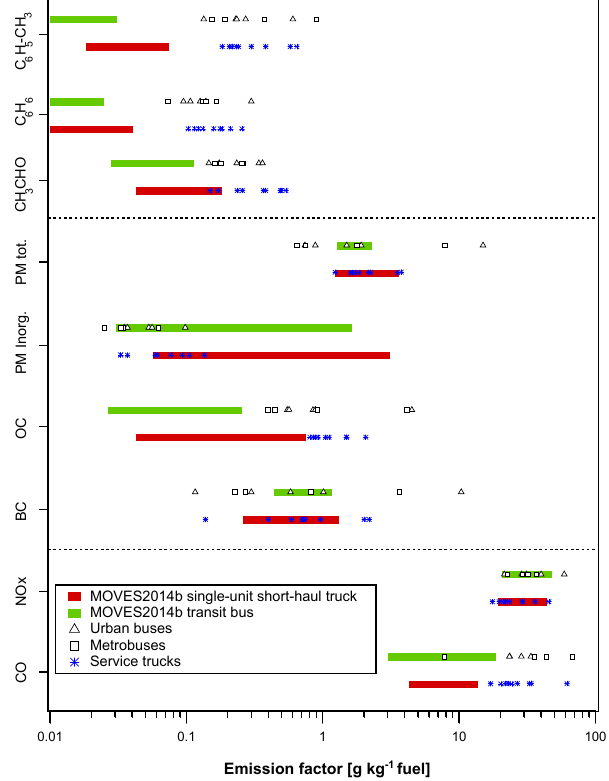
Figure 5. Comparison between AML measurements and MOVES2014 Mexico emission